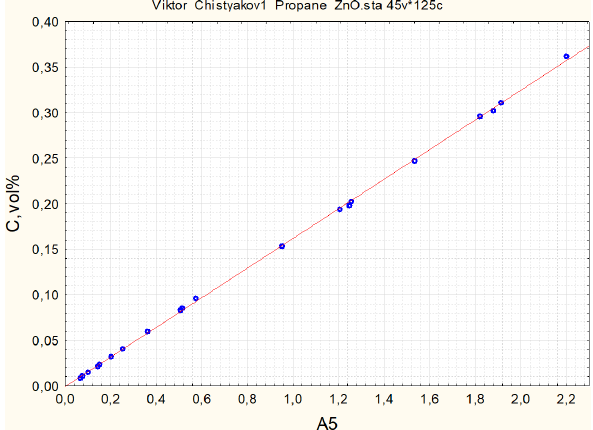
Figure 16. Ideal proportional dependence C ( A 5 ) for propane (ZnO- based